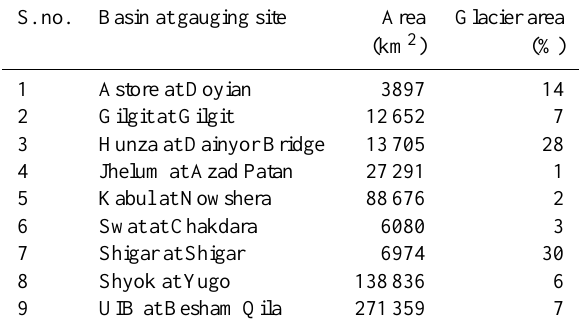
Table 1. Study basins, their areas and glacier coverage. Note: glacier areas are derived from the Randolph Glacier Inventory (Pfeffer et al.,